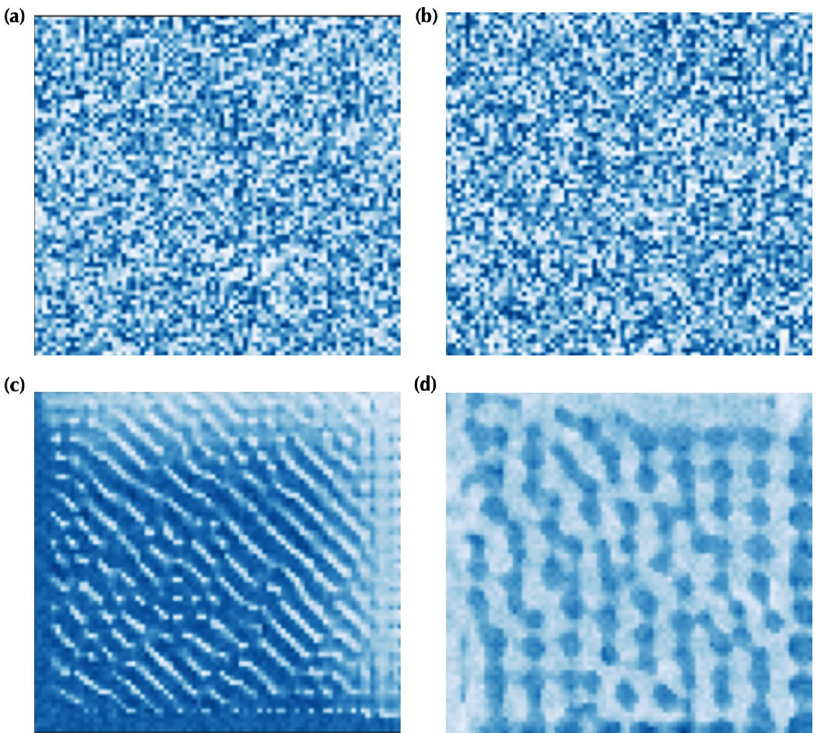
Fig. 6 Visualization of CNN fi lters. Random image a and activations of three fi lters of three consecutive CNN layers of a DCNN trained with NC are visualized in b – d